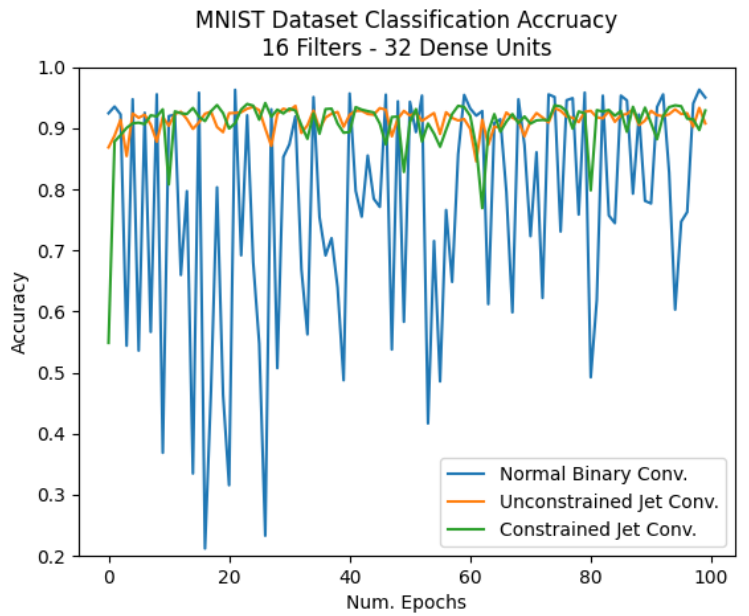
Figure 12. Classification accuracy on the MNIST dataset with 16 filters and 32 dense